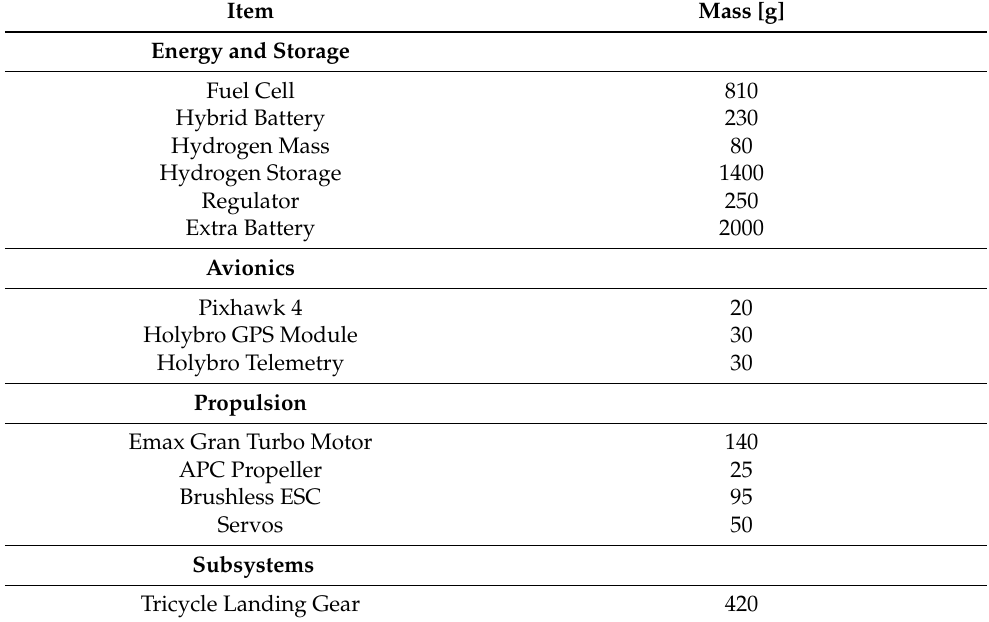
Table 2. Fixed items